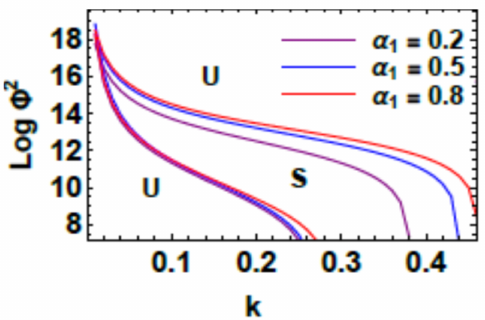
Figure 16. Variation of Log Φ 2 with k to depict the contribution of Equations (53) and (54) along with data A for different values the parameter α 1 .